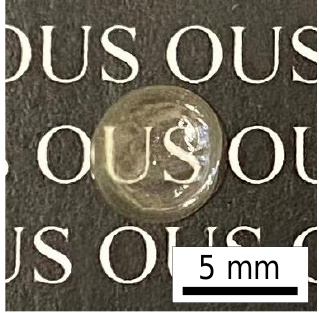
Figure 1. Photograph of F−20 wt% SiNSi composite film stripped from the Teflon ® plate under a dried condition. The thickness of composite film was approximately 100 μ m. The scale bar represents 5 mm.